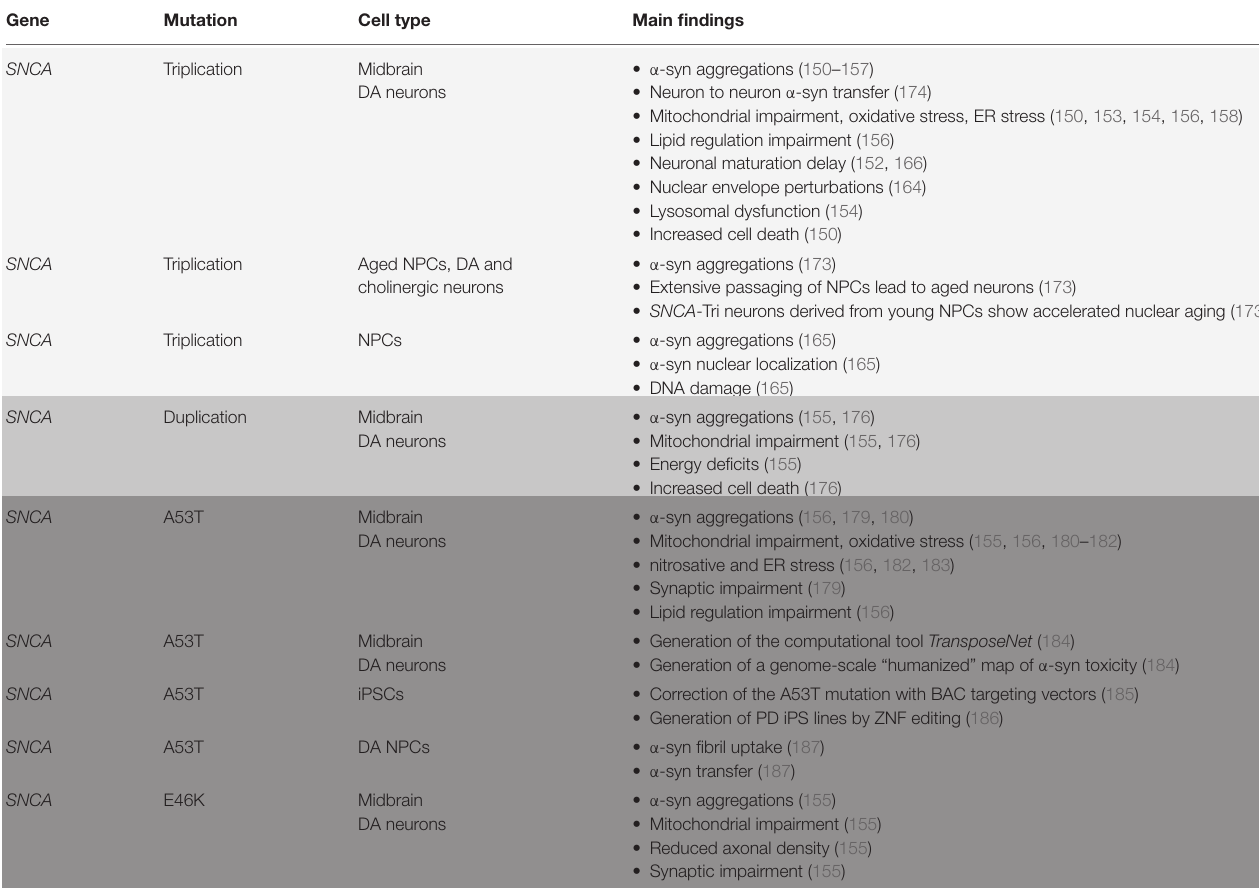
TABLE 1 | Summary on 2D models using iPSC and iPSC-generated neuronal cells having a PD- SNCA -related genetic background.